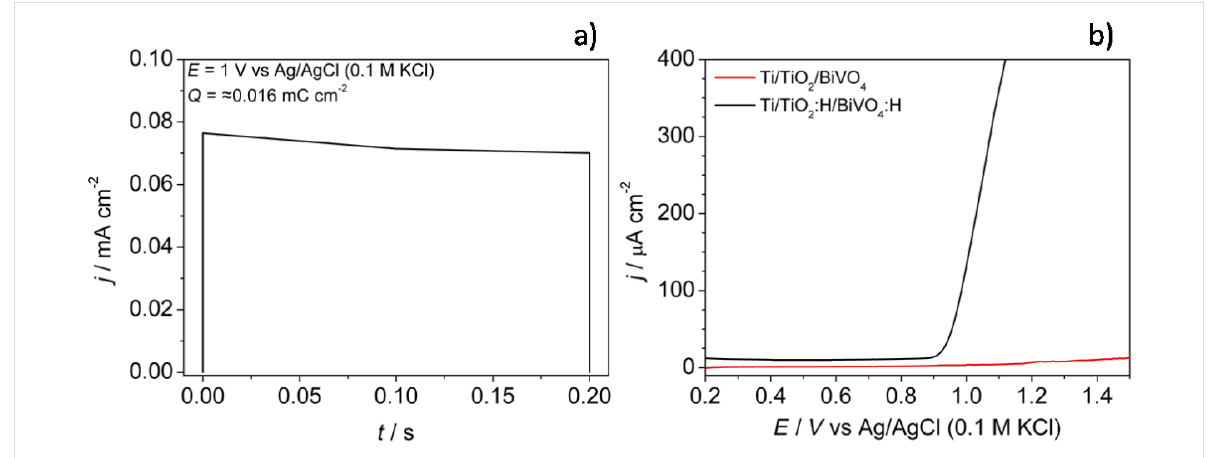
Figure 1: a) The chronoamperometry curve (single pulse at E = 1 V vs Ag/AgCl (0.1 M KCl)) recorded during PEDOT:PSS electropolymerization on a Ti/TiO 2 :H/BiVO 4 :H electrode and b) the linear sweep voltammograms recorded during polarization of Ti/TiO 2 /BiVO 4 and Ti/TiO 2 :H/BiVO 4 :H elec- trodes in aqueous electrolyte containing monomer EDOT (1 mM) and NaPSS (0.1 M). Scan rate: 20 mV s − 1 , the electrode geometric surface area was equal to 0.5 cm 2 .